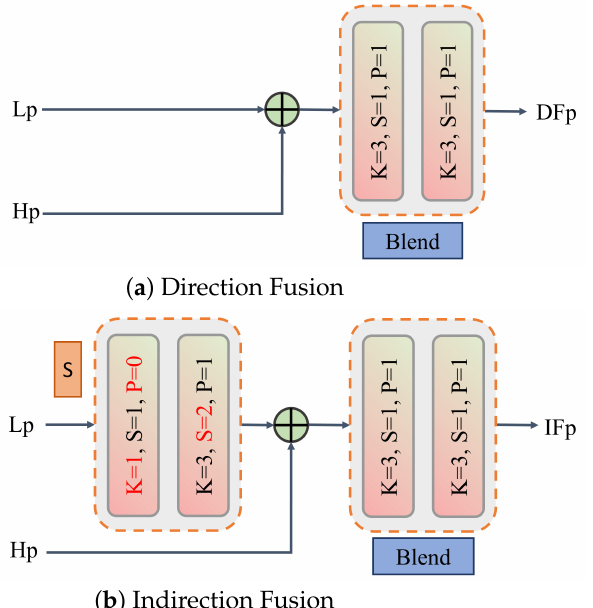
Figure 5. Multiscale feature fusion module. ( a ) is the direct fusion with the same feature map resolution and size. ( b ) denotes indirect fusion with feature maps of two different